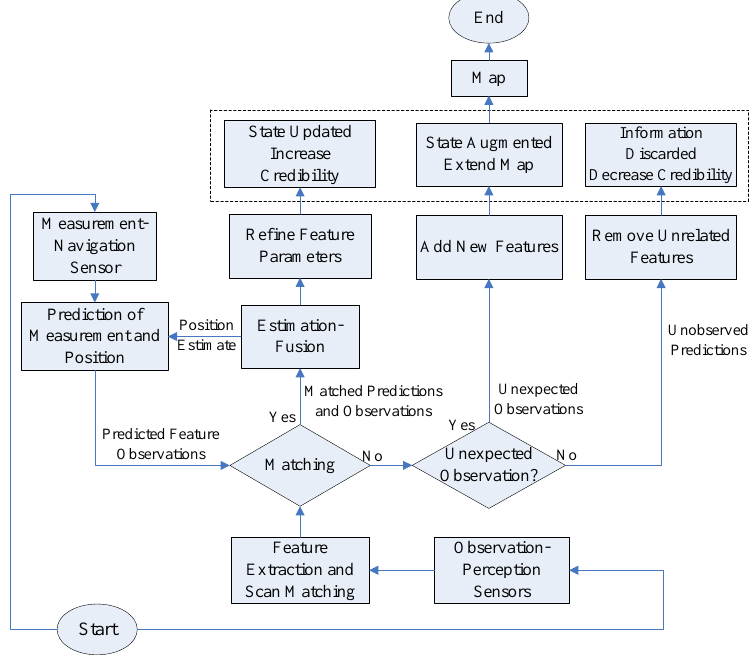
Figure 9. The flow chart of SLAM procedure based on an AEKF, modified in [7].